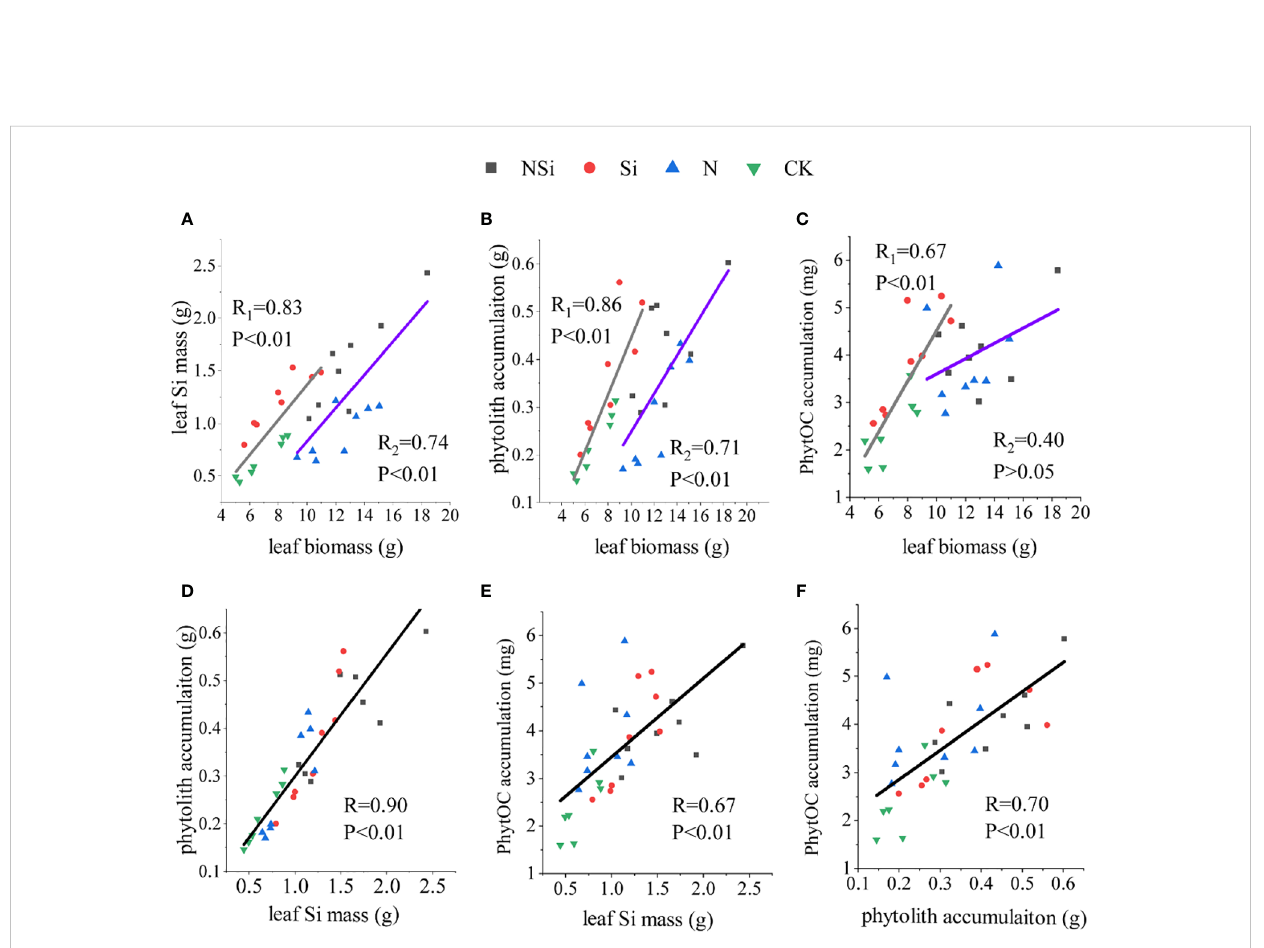
FIGURE 4 Correlation of (A) biomass with Si mass, (B) biomass with phytolith accumulation, (C) biomass with PhytOC accumulation, (D) Si mass with phytolith accumulation, (E) Si mass with PhytOC accumulation, and (F) phytolith accumulation with PhytOC accumulation in Moso bamboo leaves. CK, N, Si, and NSi represent the level of fertilization at 0N 0Si kg/hm 2 , N157.5 kg/hm 2 , Si 315 kg/hm 2 , N157.5 kg/hm 2 and Si 315 kg/hm 2 , respectively. R 1 represents the correlation coef fi cient between Si fertilizer and NSi fertilizer treatment. R 2 represents the correlation coef fi cient between N fertilizer and CK